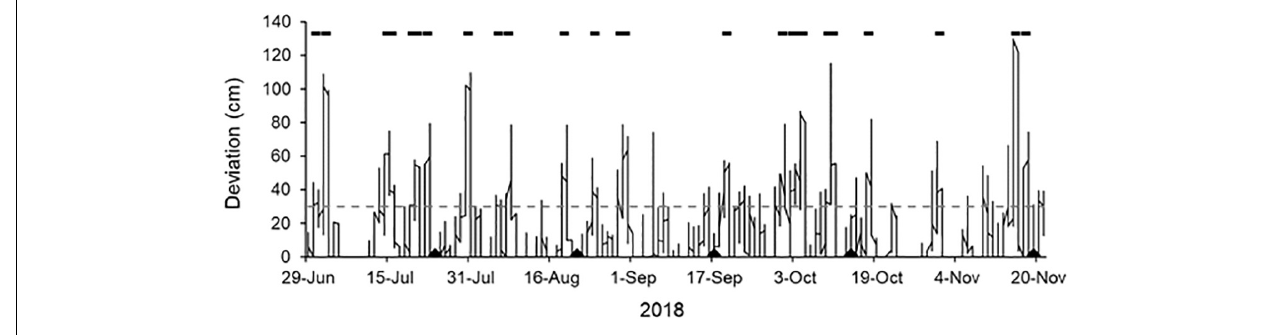
FIGURE 7 | Positive deviations in the tide relative to tidal predictions during the experimental period. The black bars above the curve indicate storms, defined as periods with deviations > 30 cm (gray dashed line) lasting for more than 6 h (see Fiore et al., 2009). Sampling dates are indicated as triangles on the x -axis. Tidal records were obtained from the tide gauge at Puerto Mar del Plata (38 ◦ 02 (cid:48) 08 (cid:48)(cid:48) S, 57 ◦ 31 (cid:48) 52 (cid:48)(cid:48) W, ∼ 35 km north of the study site). Tidal records and predictions were provided by the Servicio de Hidrografía Naval, Ministerio de Defensa, Argentina.